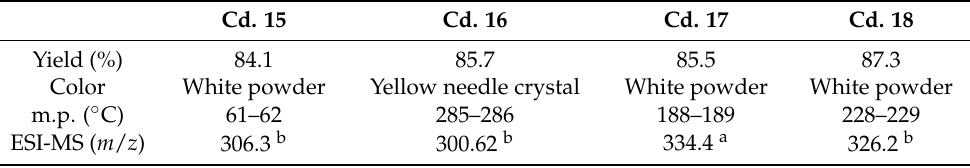
Table 5. The yields, colours, and ESI-MS data of Cds. 15 – 18 .